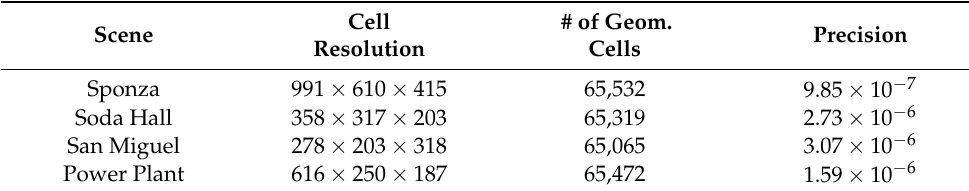
Figure 1. Quantization of 3D geometry data. Table 2. Partitioning the scene’s AABB into cubic cells. The scene’s AABB is subdivided into cubic cells whose size is chosen to be as fine as possible, while the number of geometry cells, which intersect with an object (“# of geom. cells”), cannot exceed 65,536 (=2 16 ). In the table, “Cell resolution” shows how finely the scene space is tessellated in cubic cells. The found geometry cell is further subdivided into 1024 3 voxels, and "Precision” indicates the voxel size relative to the length of the longest axis of the